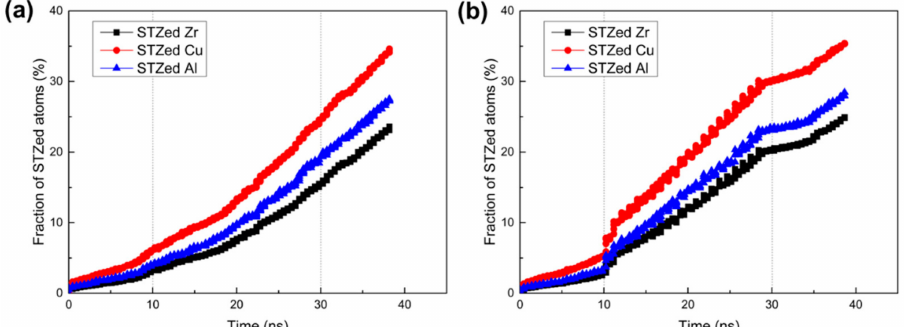
Figure 5. The evolution of the fraction of S atoms in each atom type during tension, ( a ) without vibrational loading and ( b ) with vibrational